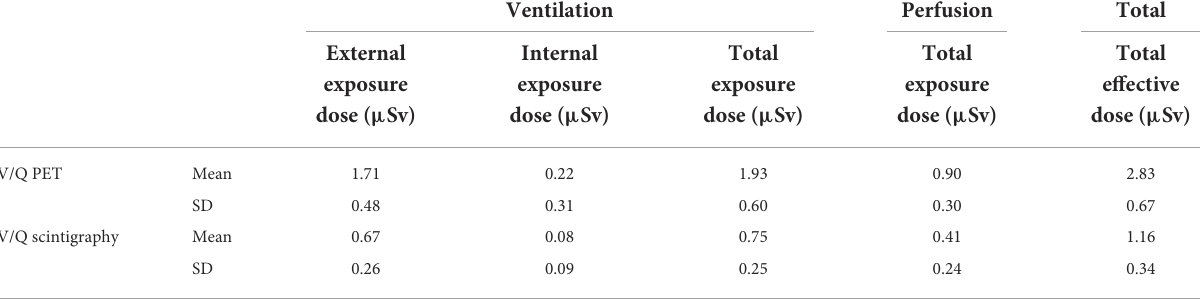
TABLE 1 Results of effective doses due to pulmonary ventilation and perfusion, and total effective dose according to the radionuclide used to performed V/Q